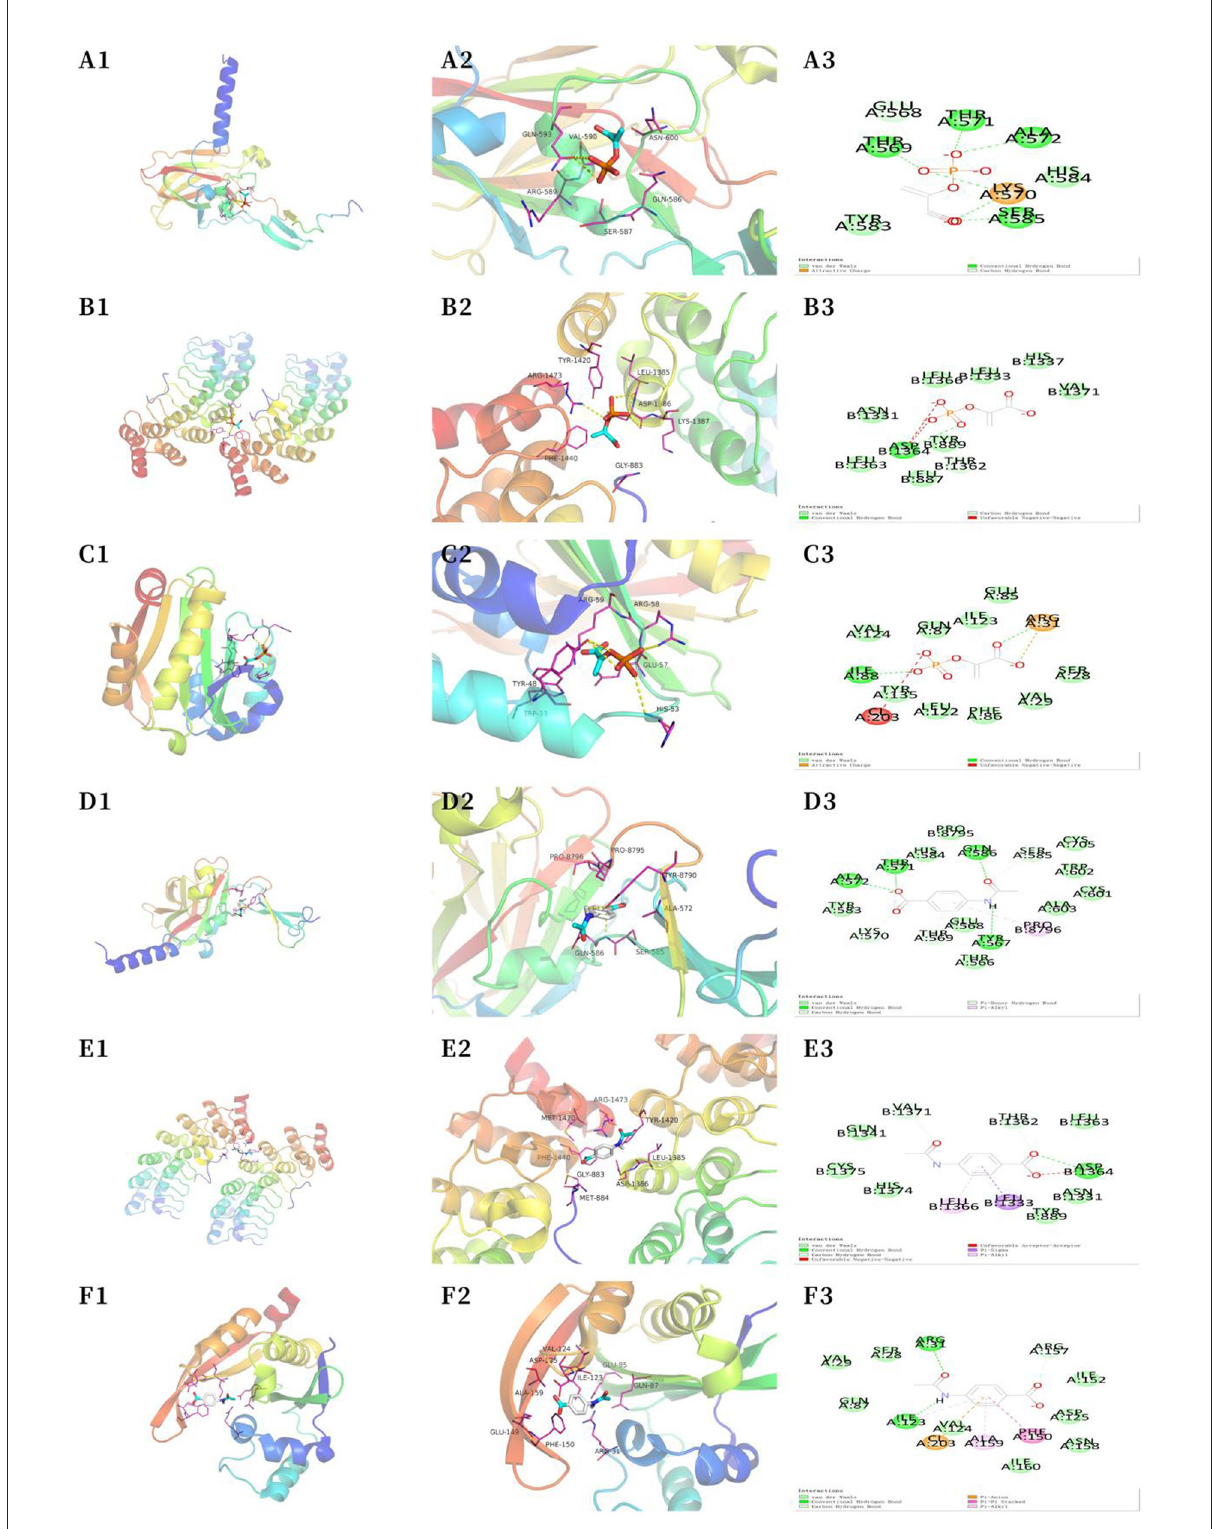
FIGURE6 Molecular docking analysis. (A) SYNE1 phosphoenolpyruvate (macroscopic) (A1) ; SYNE1 phosphoenolpyruvate (microscopic) (A2) ; SYNE1 phosphoenolpyruvate (A3) . (B) ANK2 phosphoenolpyruvate (macroscopic) (B1) ; ANK2 phosphoenolpyruvate (microscopic) (B2) ;